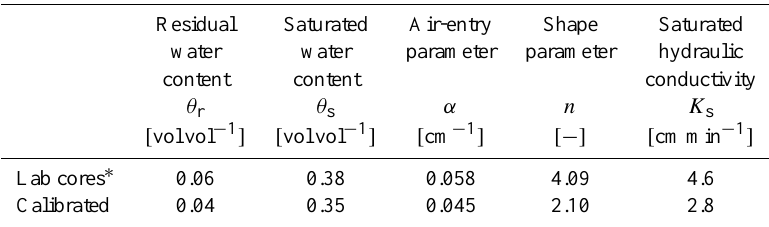
Table 1. Sand hydraulic parameters used in HYDRUS-1D simulations. Lab core measurements were used as initial parameters in the HYDRUS-1D